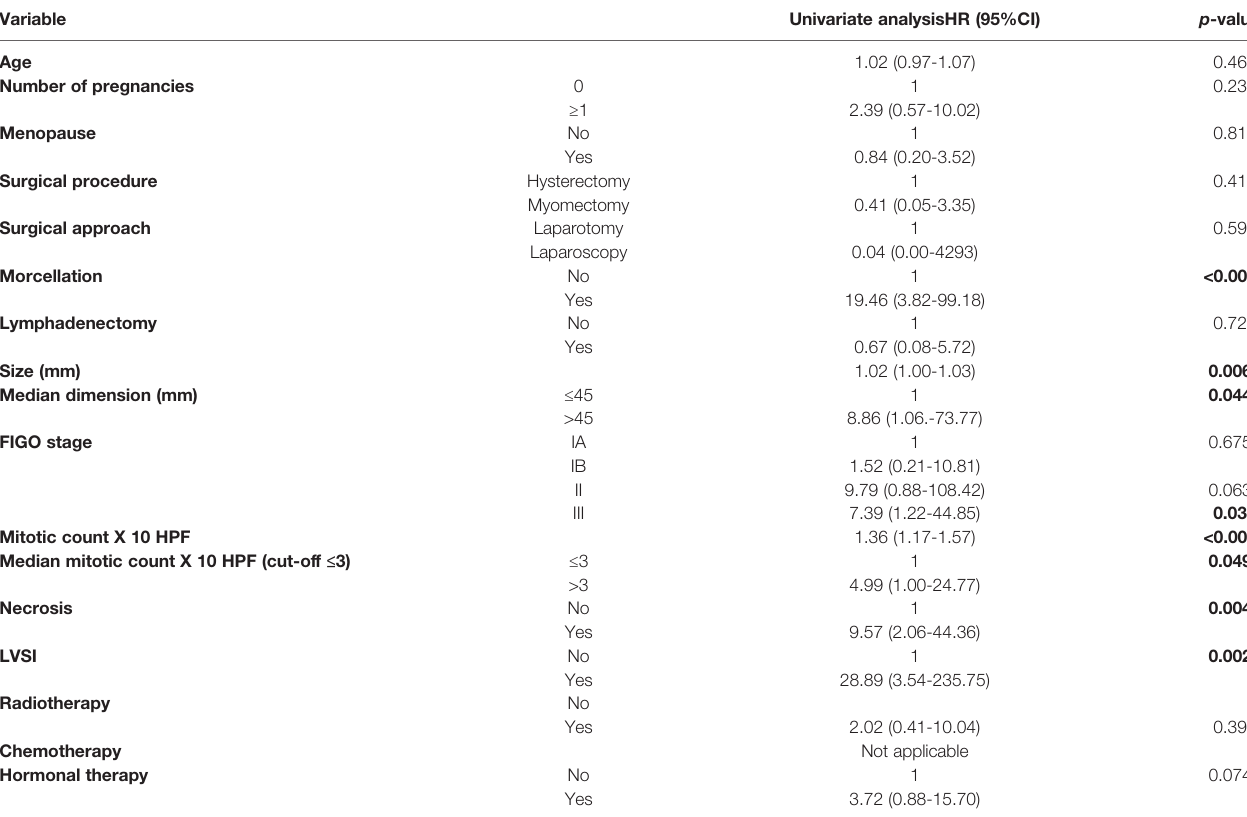
TABLE 2 | Univariate analysis of the variables associated with LG-EES recurrence (in bold signi fi cant p -values).